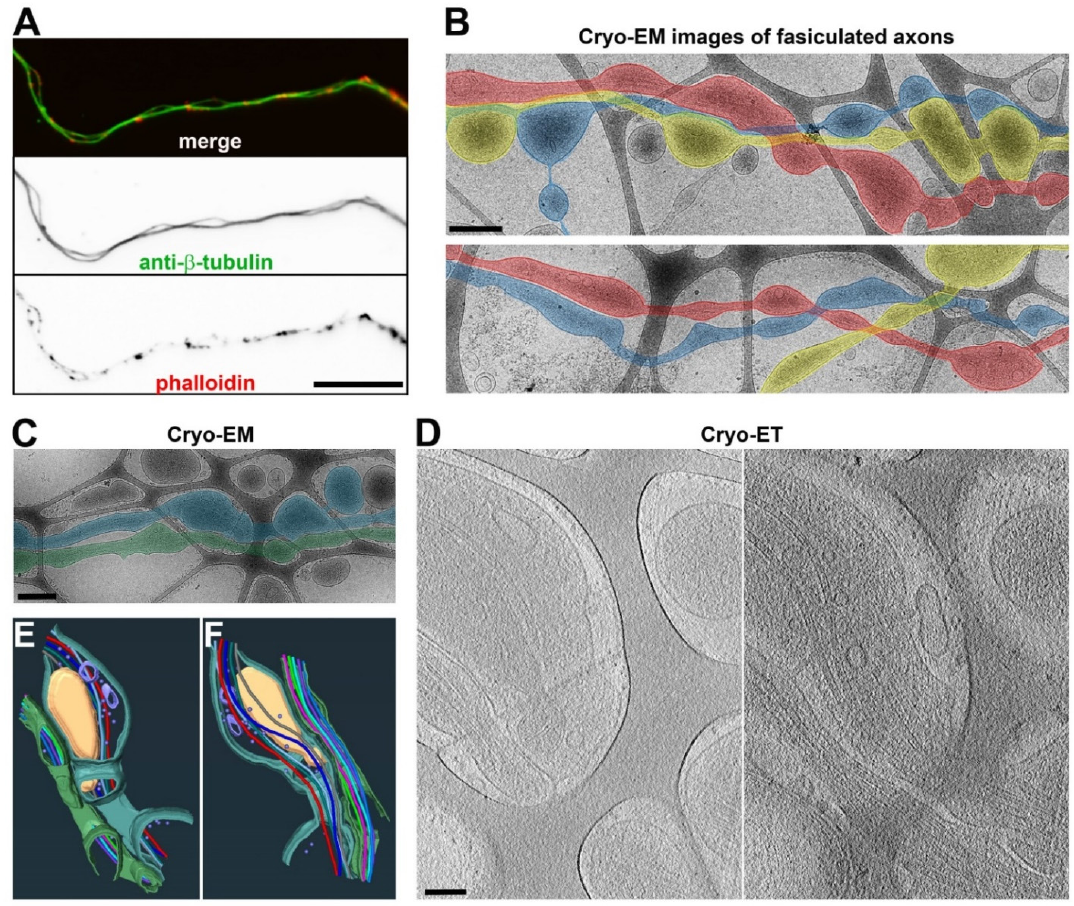
Figure 7. Three-dimensional ultrastructures of fasciculated axons. ( A ) Two fasciculated axons growing on coated glass coverslips stained with an anti- β -tubulin antibody (green) and phalloidin